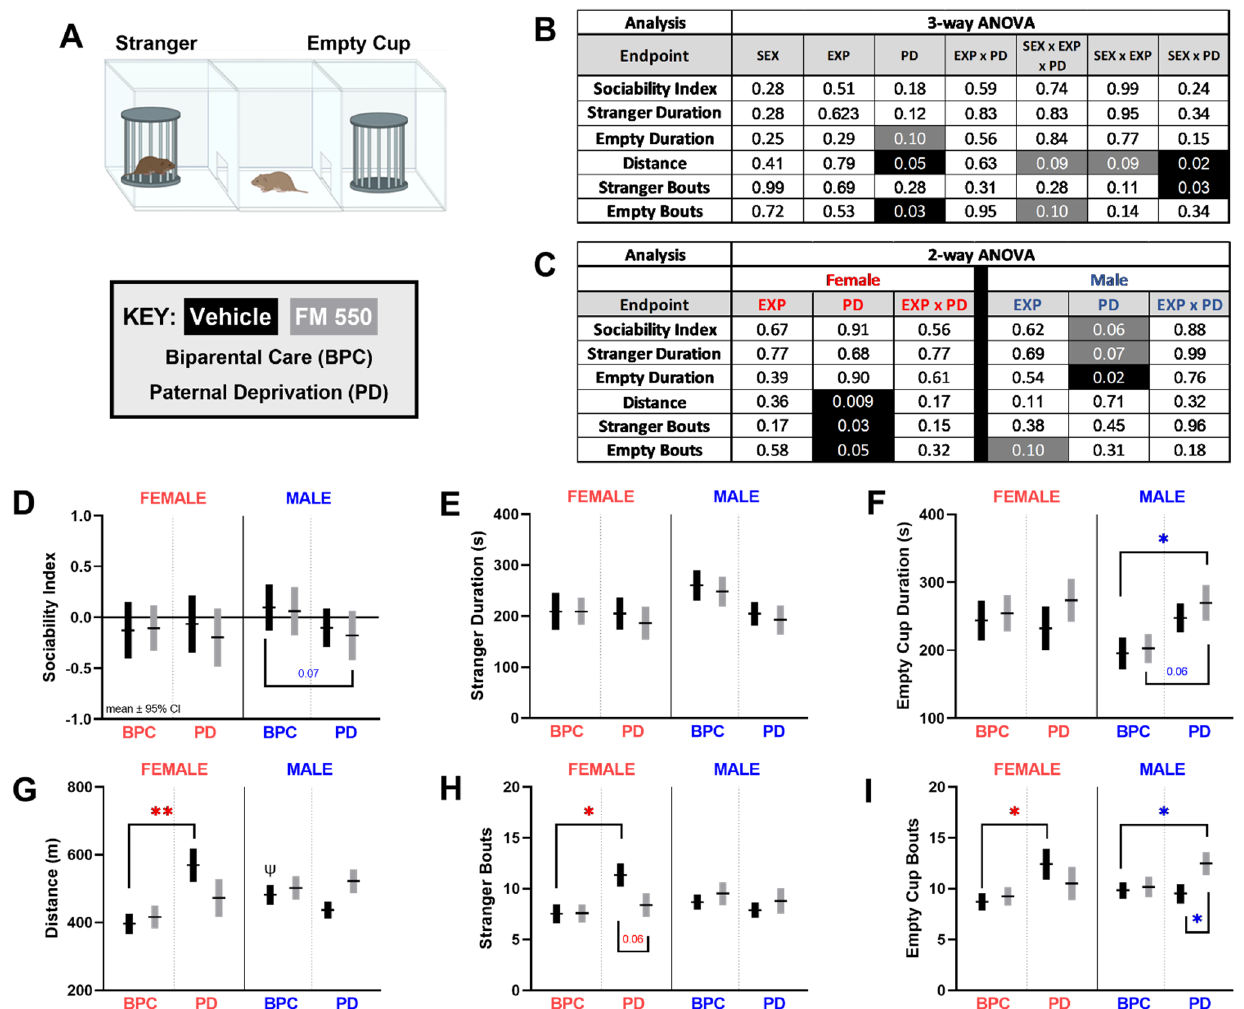
Figure 3. Sociability test. ( A ) Arena schematic depicting placement of each element. ( B ) Three-way ANOVA p -values for main effects of sex, FM 550 exposure, and paternal care and ( C ) Two-way ANOVA p -values for each endpoint. Significant effects are highlighted in black and suggestive effects ( p ≤ 0.10) are highlighted in grey. Main effects were primarily driven by paternal deprivation ( B ) and primarily in females on the exploratory endpoints in the task ( C ). The sociability index revealed no preference for either cup in any group, however, a suggested lower sociability index PD + FM 550 males compared to BPC males ( D ). No significant differences in duration with strangers were found in either sex ( E ) however, there was a suggestive paternal care effect in males. PD females traveled more ( G ) with more entries with the stranger ( H ) and empty cup ( I ) than BPC females. PD + FM 550 males visited ( I ) and spent more time with the empty cup than BPC males (F). Graphs ( E – I ) depict mean ± SEM and ( D ) depicts mean ± 95% CI. For each dose ( n = 15–28); * denotes a statistically significant difference between groups within sex, while ψ denotes significant sex differences between BPC controls. A single symbol represents p ( * , ψ ) ≤ 0.05 and a double symbol represents p ( ** ) ≤ 0.01. For the sociability index, a significant difference from chance (SI = 0, solid line). A sociability index of 1.0 indicates preference for stranger animal and an index of − 1.0 indicates preference for the empty cup.